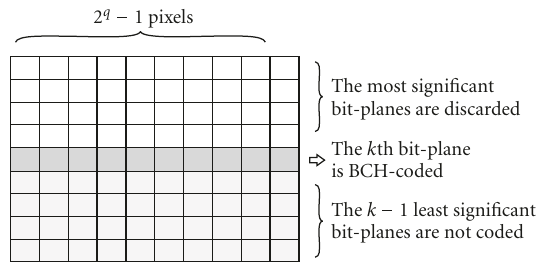
Figure 3: Bit-plane coding by means of the vector DSC coder. The k th bit-plane is BCH-coded, whereas the k − 1 least significant bit- planes are transmitted